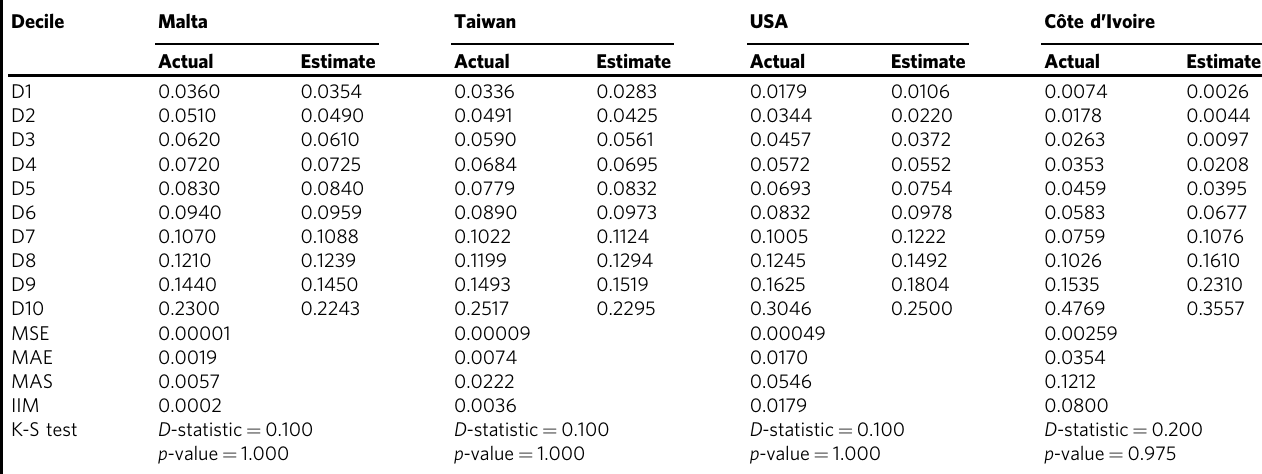
Table 4 The comparison between the actual and the estimated income shares by decile calculated using the simple method that utilizes the data on the Gini index and the income shares of the bottom 5% and the top